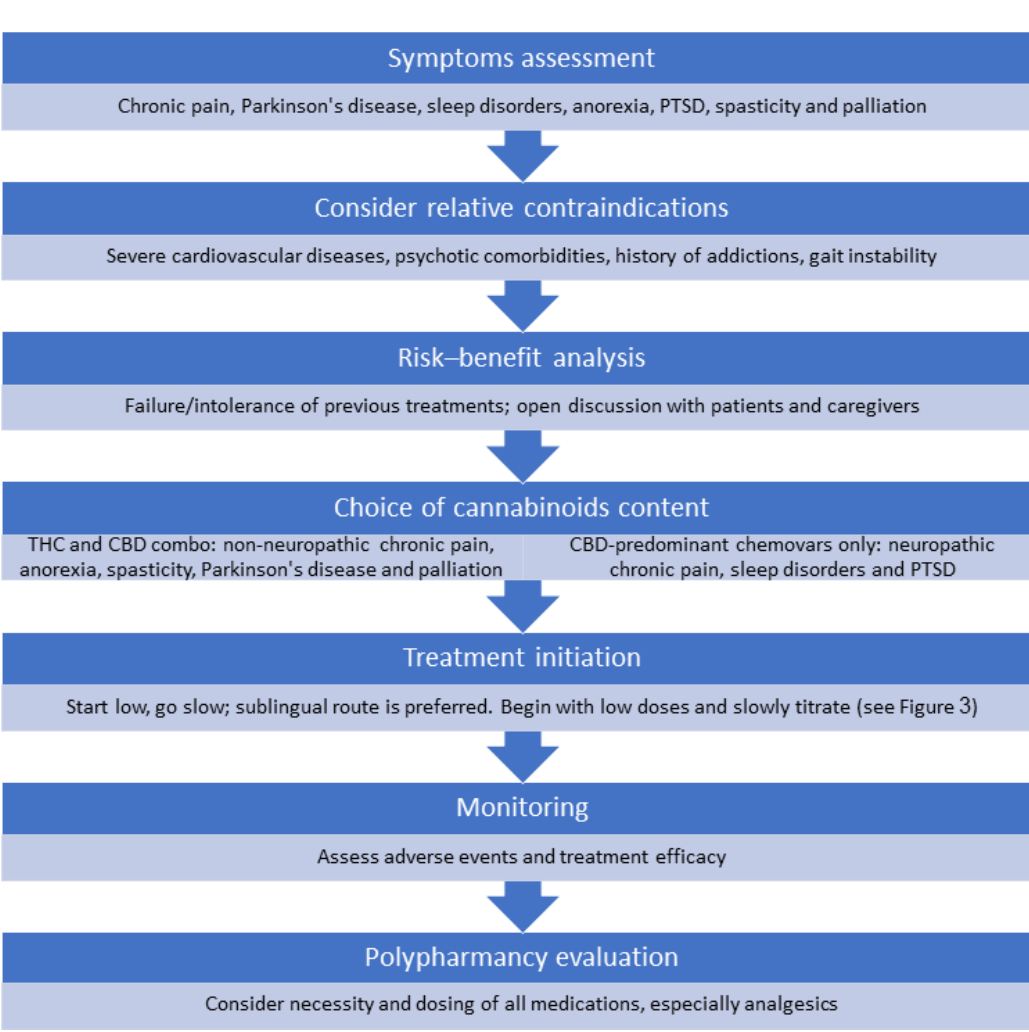
Figure 2. Practical approach to cannabis treatment in older adults. PTSD — post-traumatic stress disorder, THC — tetrahydrocannabinol, CBD — cannabidiol.